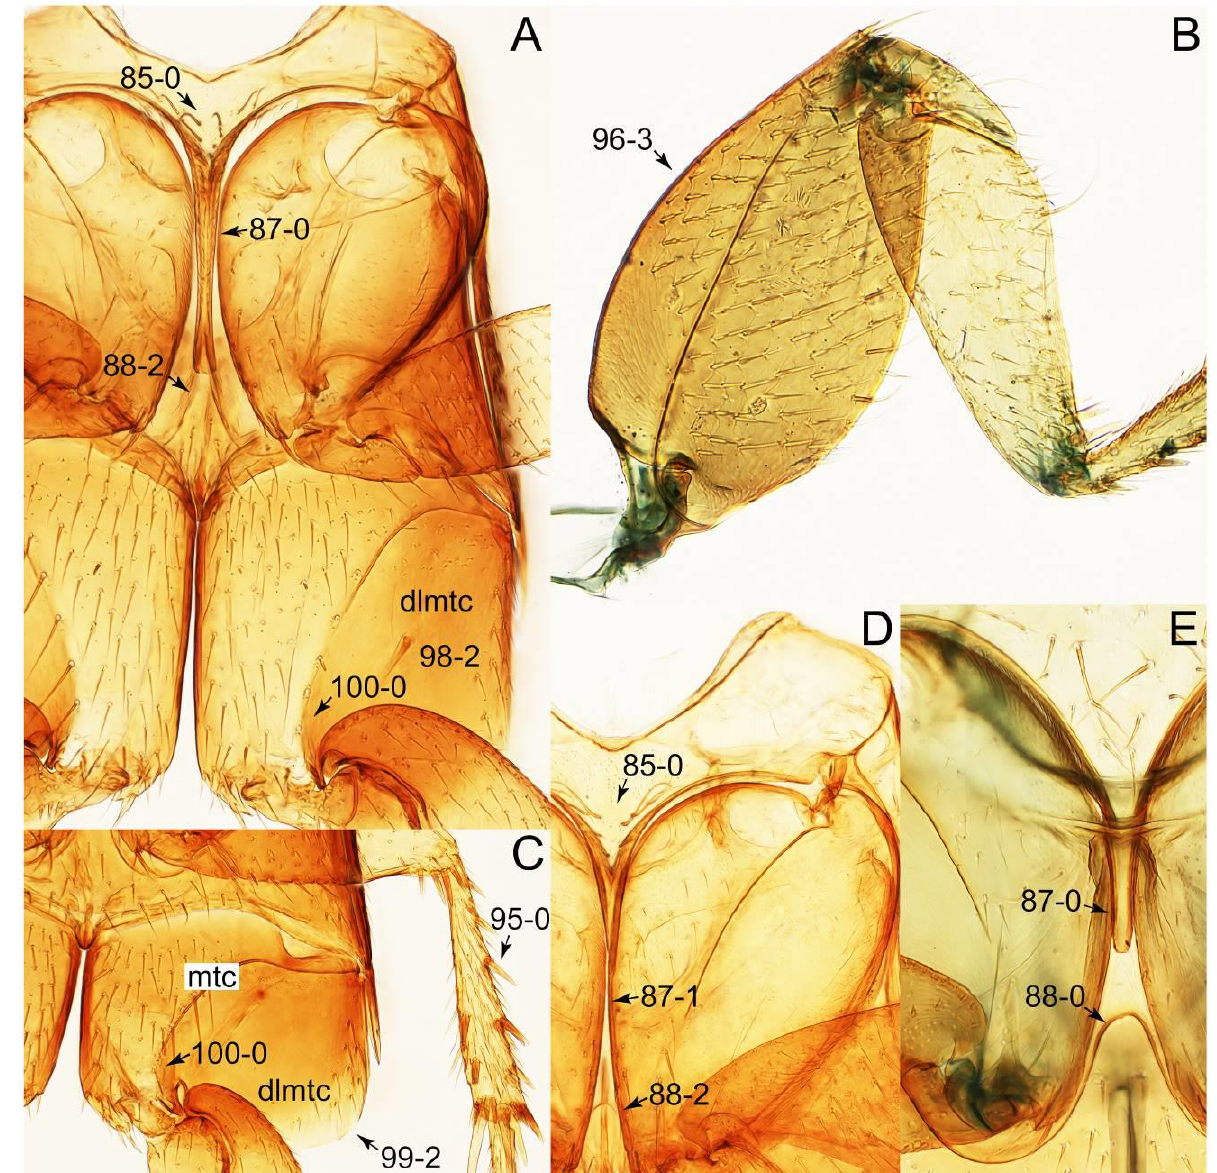
Figure 70. Photographs of body parts of Mycetoporinae, enlarged. ( A ) mesothorax and metathorax of Ischnosoma splendidum , ventral view. ( B ) right foreleg of Bryoporus rufescens , frontal view. ( C ) left mesotibia and metacoxa of Mycetoporus punctus , ventral view. ( D ) intermesocoxal processes of Parabolitobius formosus , ventral view. ( E ) intermesocoxal processes of Carphacis effrenatus , ventral view. Abbreviations: dlmtc, dorsal lamella of the metacoxa; mtc, metacoxa. Characters and character states (format X-X) are indicated on each